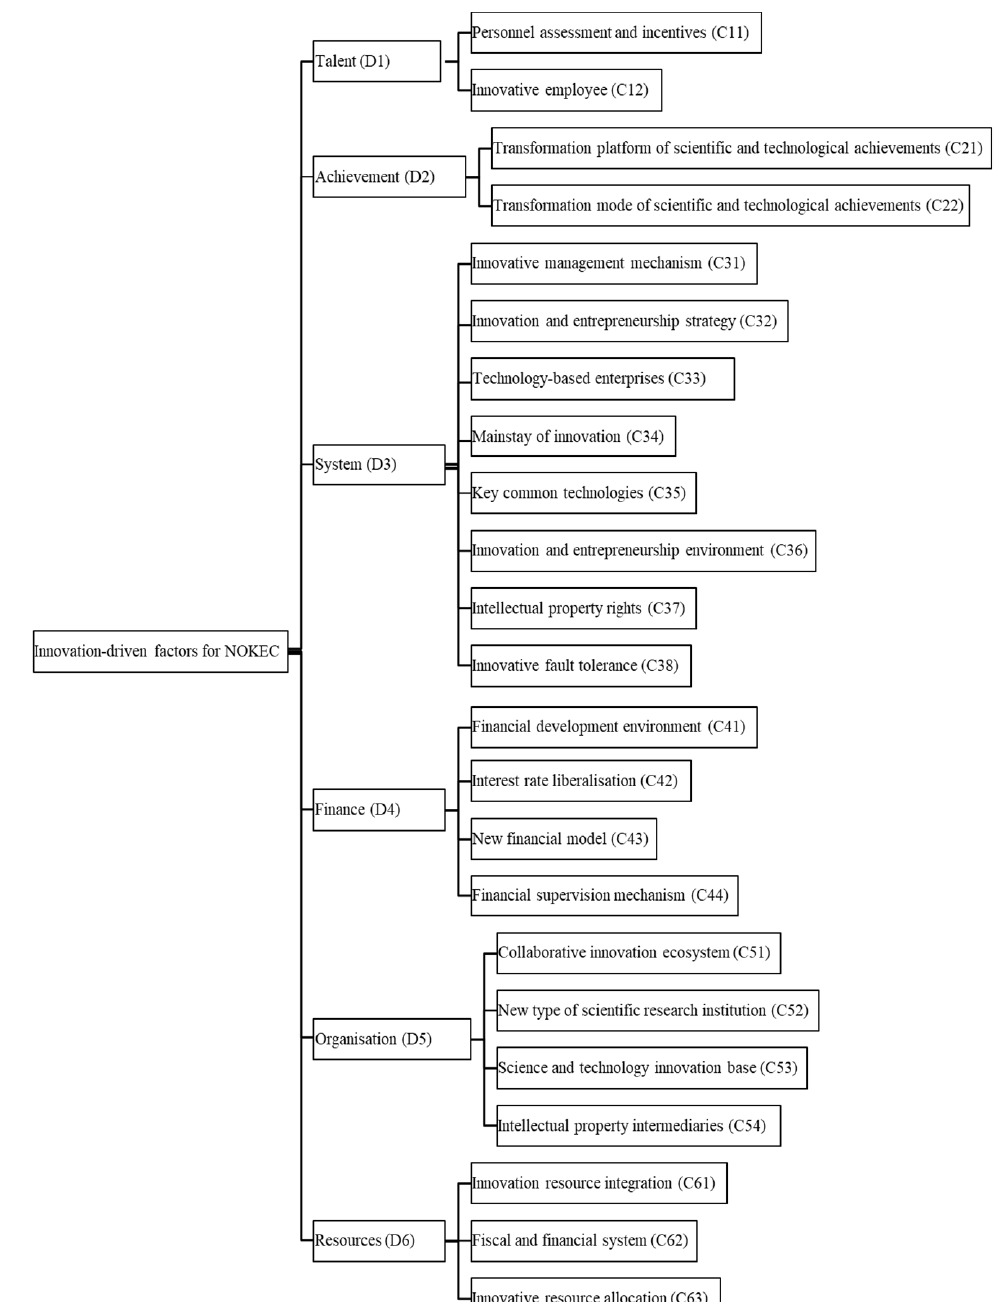
Figure 1. Hierarchy of innovation-driven factors for NOKEC.